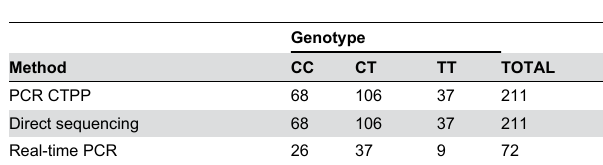
Table 2. distribution of genotypes according to the methods.